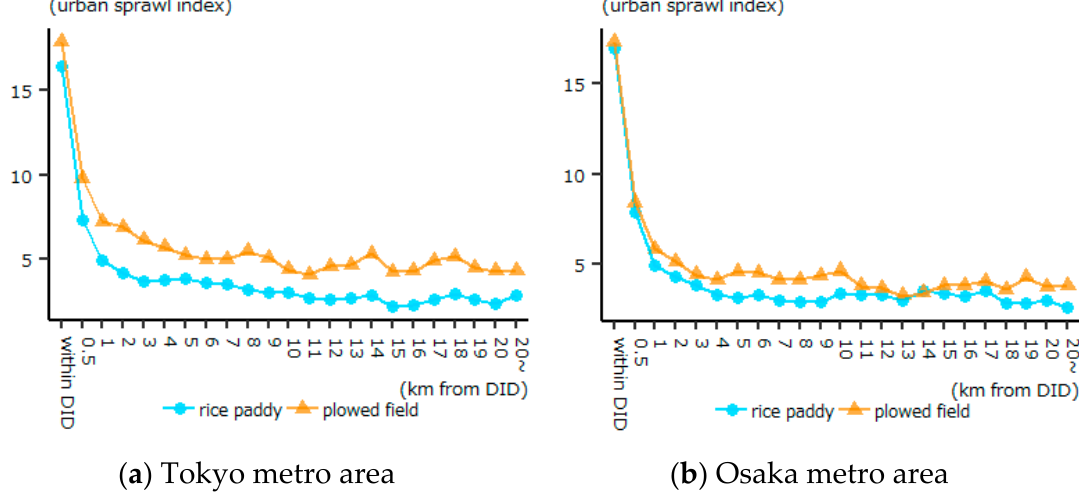
Figure 7. Average urban sprawl index by distance from DID. ( a ) shows the case of Tokyo metro area and ( b ) shows the case of Osaka metro area.